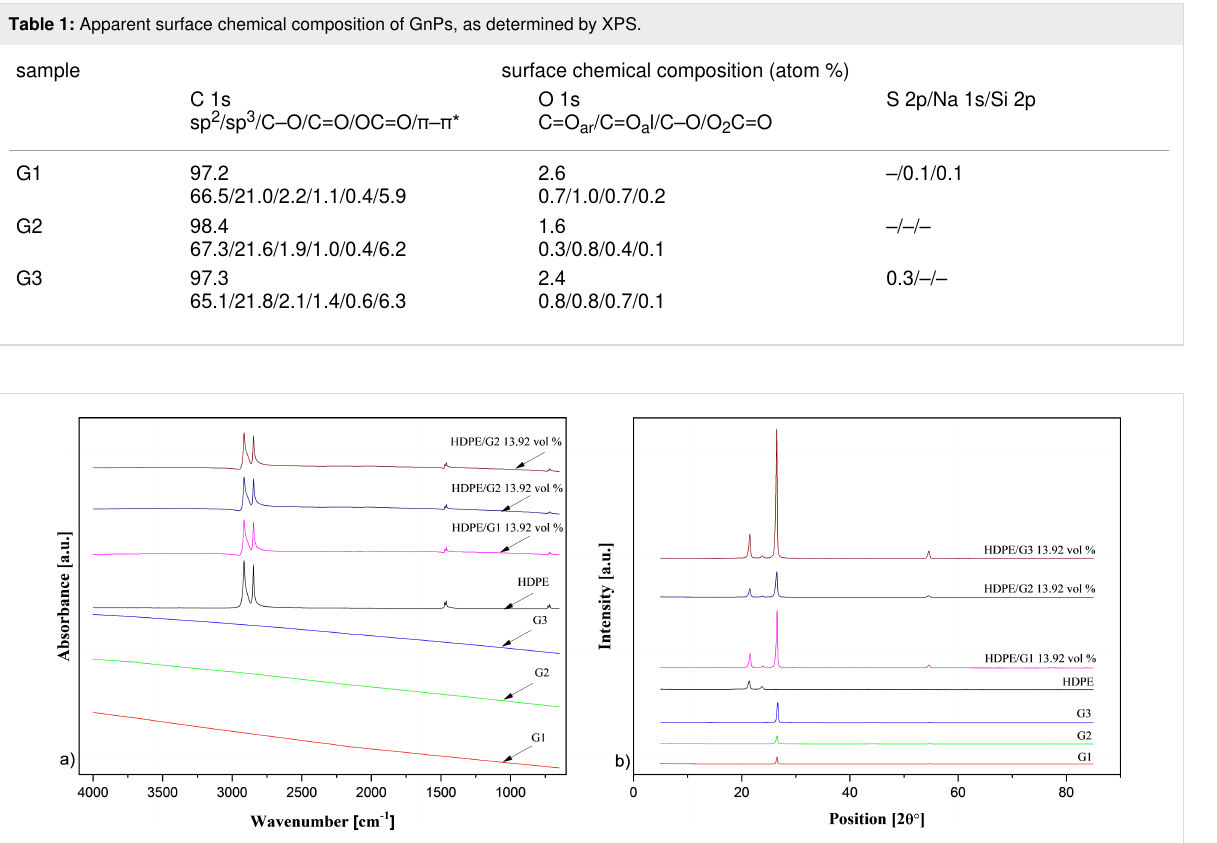
Figure 3: a) FTIR spectrum and b) XRD pattern of the GnPs, pure HDPE, and HDPE/13.94 vol % GnP nanocomposites.